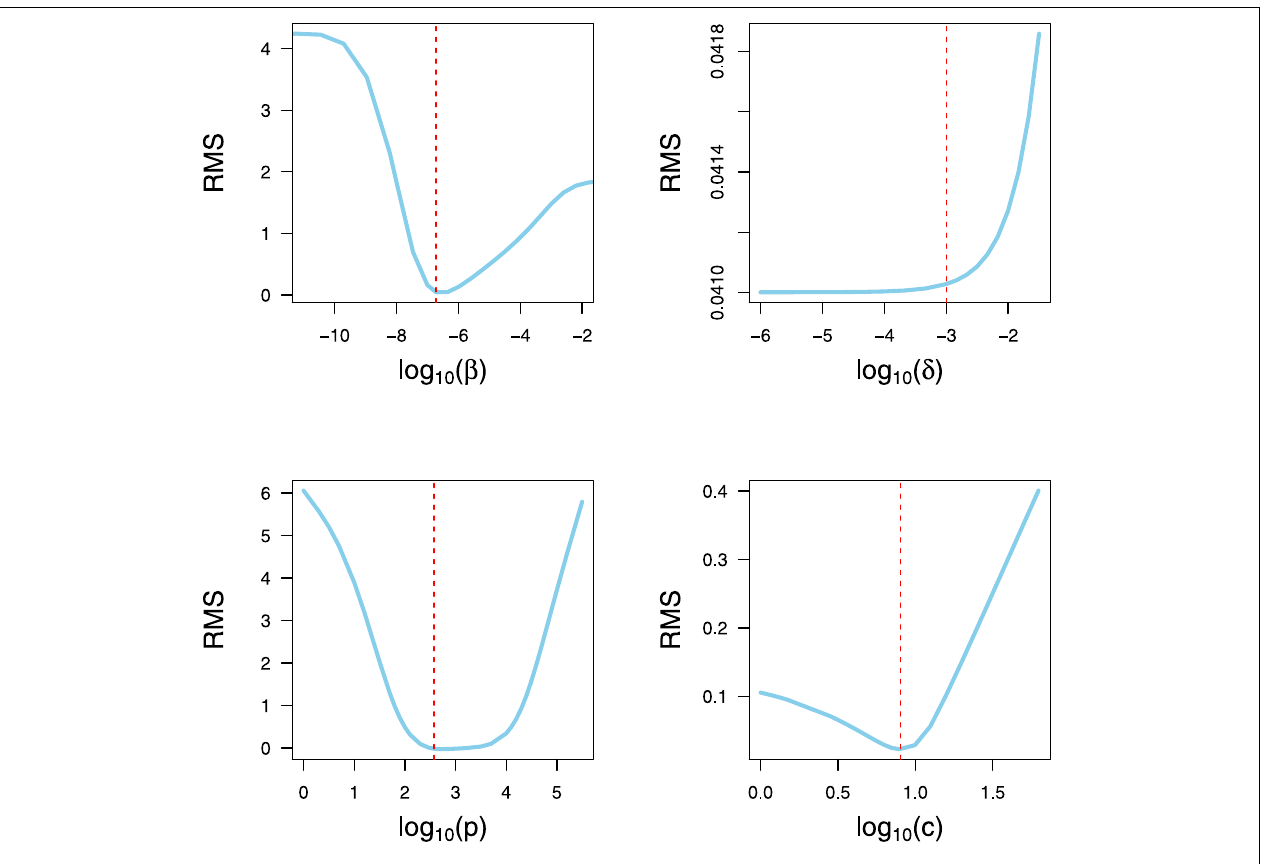
FIGURE 4 | Parameter Identifiability. RMS profile of model parameters. Each parameter is varied in a wide range around the optimized value. Subsequently, the DE algorithm is used to refit the remaining